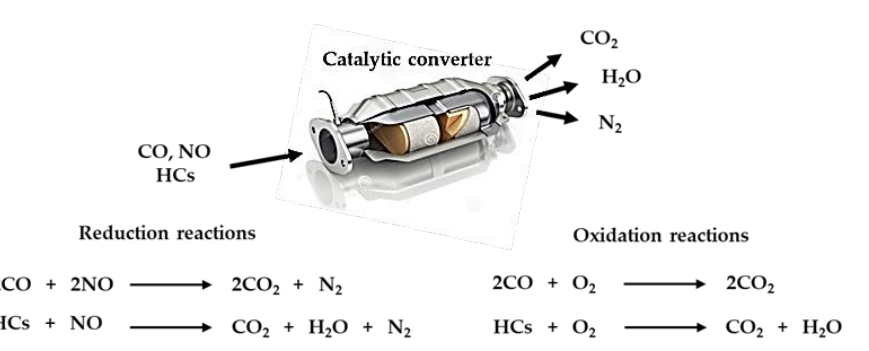
Figure 1. Reactions catalyzed by a catalytic converter.